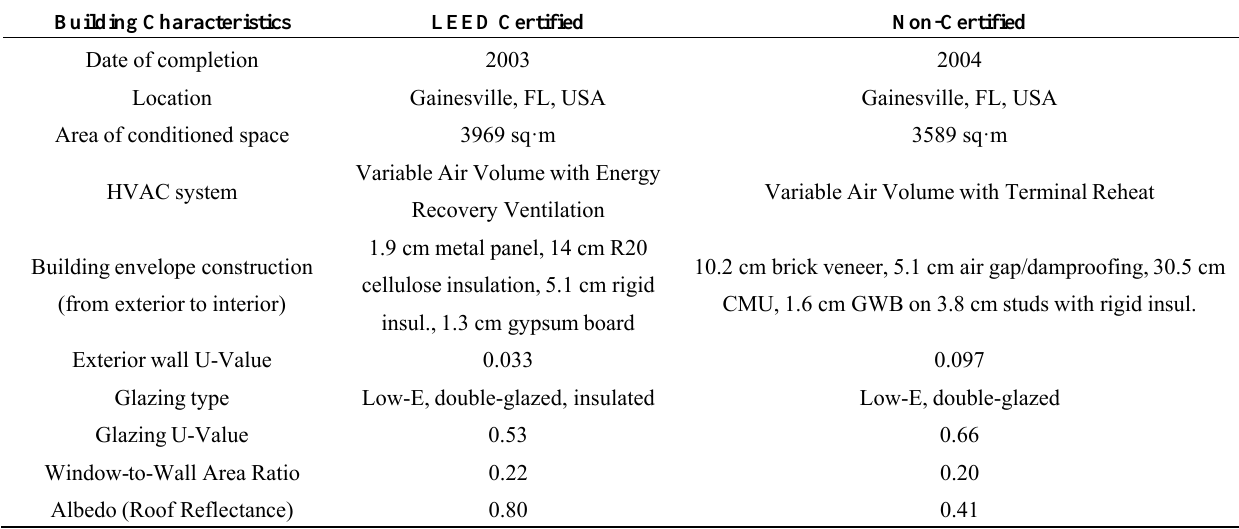
Table 1. Specifications of buildings used in the case